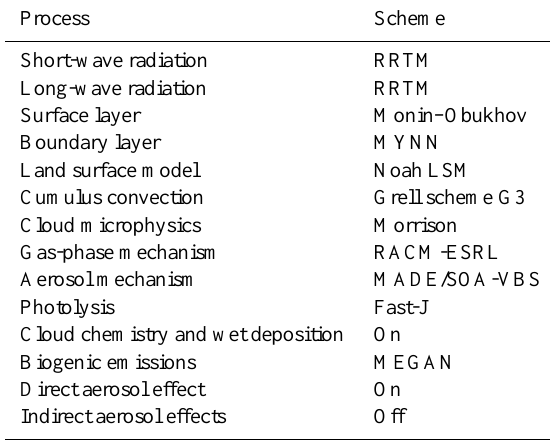
Table 1. Main physical and chemical parameterizations used in WRF/Chem simulations. For definition of acronyms please refer to main